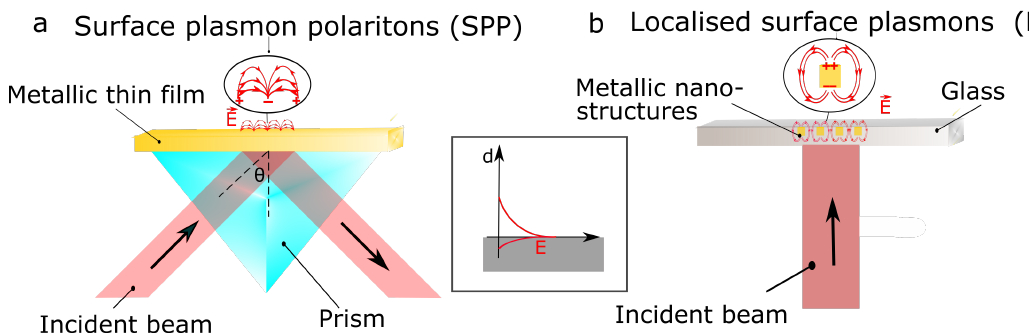
Figure 6. ( a ) Schematic of the Kretschmann configuration [42,43] used to excite the surface plasmon polaritons (SPP). Light is coupled into SPPs under total internal reflection in order to compensate for the light momentum mismatch. The angle of incidence, θ , controls both the scattering and the gradient forces, allowing for tuning of the total trapping force. ( b ) Excitation of the localised surface plasmons (LSP) can happen under direct illumination of the metallic nanostuctures. The geometrical characteristics of the nanostructures on the metallic thin film define the resonance frequency and the forces that arise from the plasmonic field. Inset shows the exponential decay of the evanescent plasmonic field from the surface of the